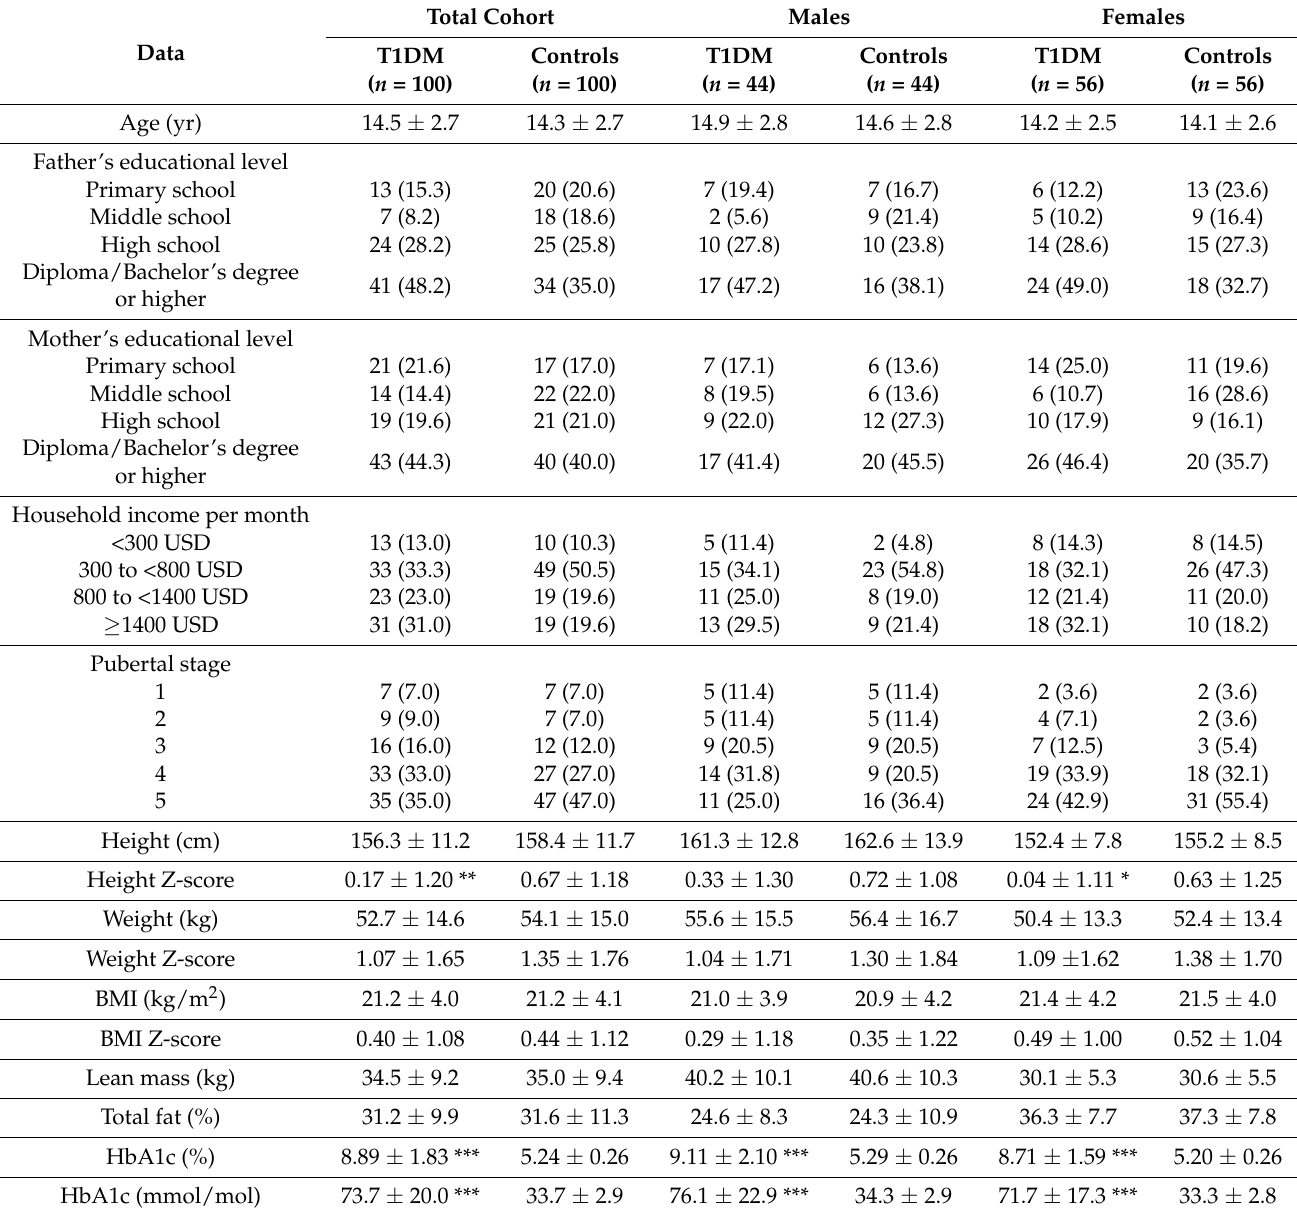
Table 2. Demographic, anthropometric, clinical, and biochemical characteristics of the entire study population, and compared between male and female study